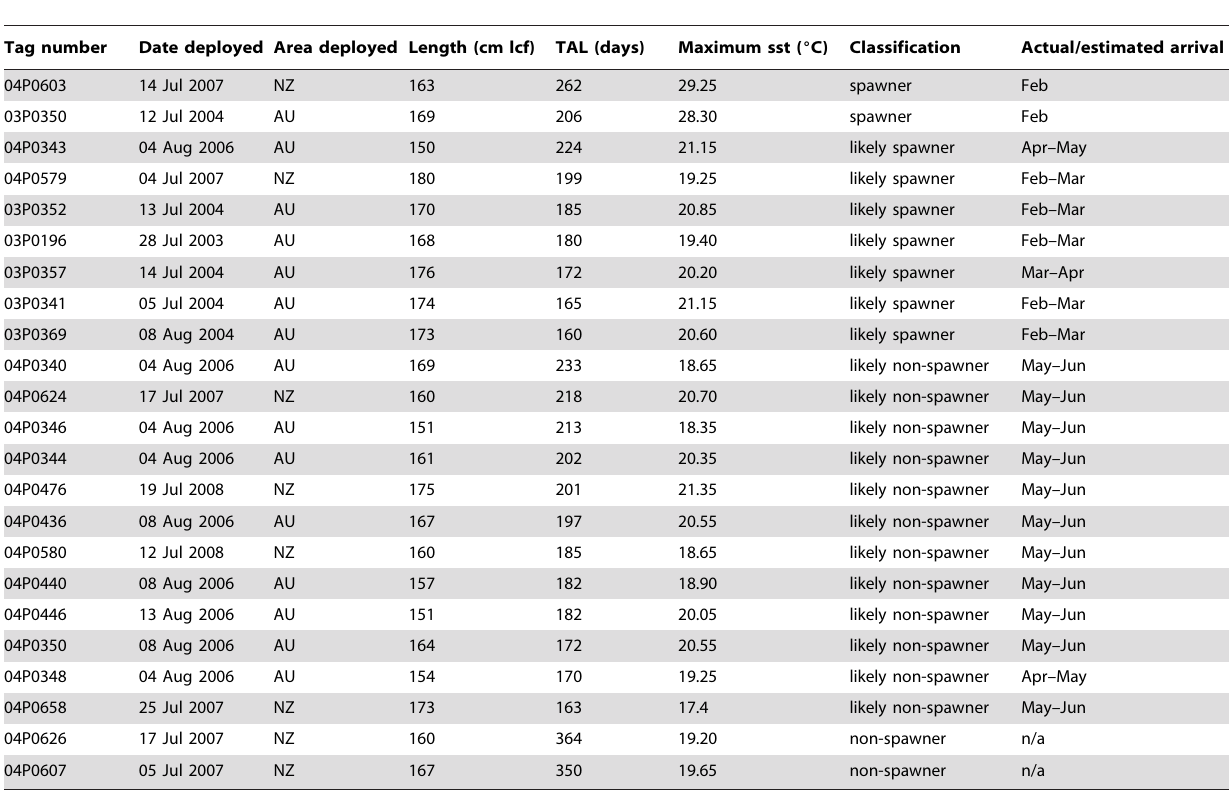
Table 1. Details of tags deployed in the Tasman Sea 2003–2008, maximum sea surface temperature experienced, spawning classification and actual or estimated month of arrival on the spawning